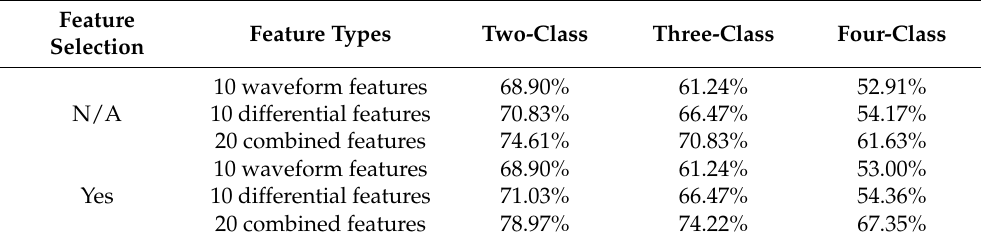
Table 5. Performance of affective computing in emotional type categorization using six-fold cross- validation method.